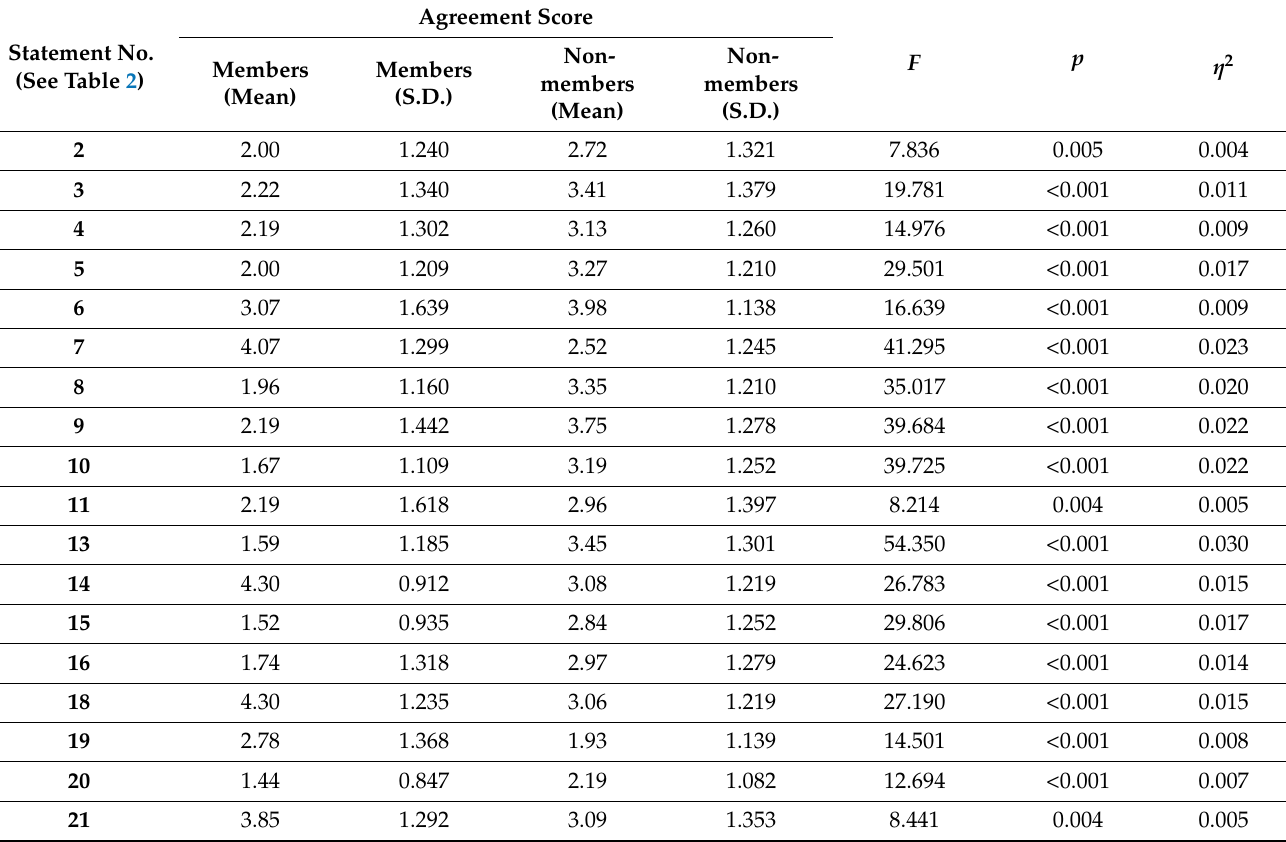
Table 3. Mean score of agreement with statements on coexistence with hooded crows by the mem- bership of hunting company of the respondents. Only 18 statements are shown for which the membership of hunting company difference was significant.